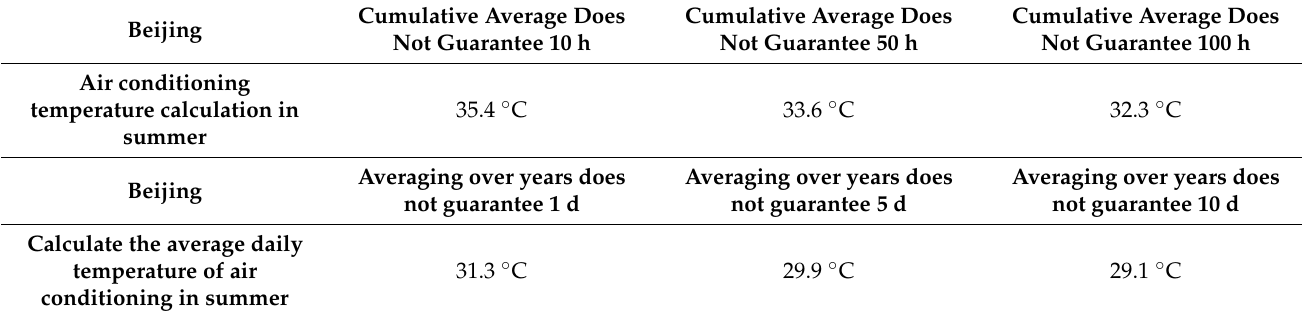
Table 10. Selection results in Beijing.